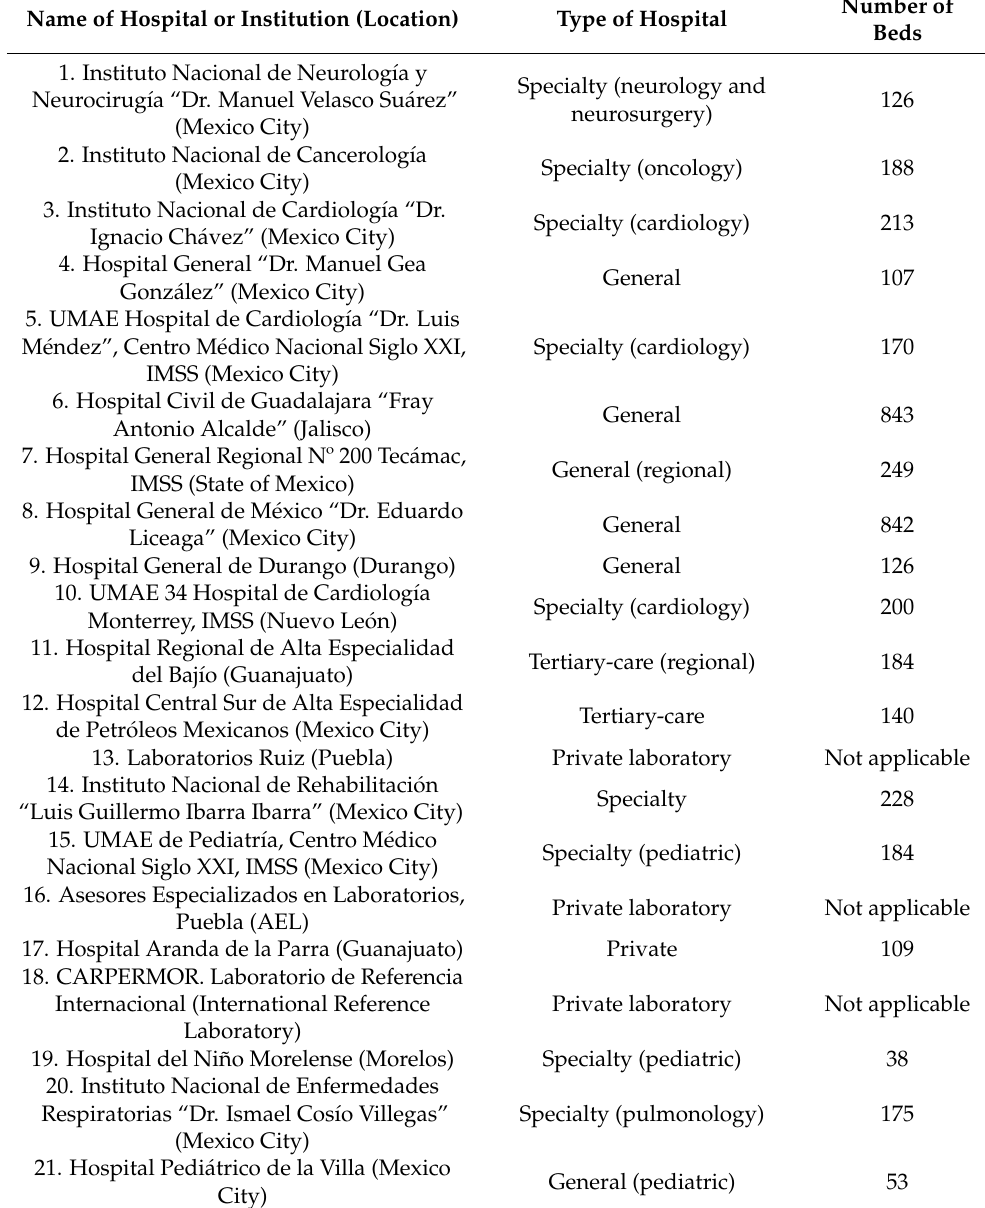
Table 1. Characteristics of hospitals/institutions participating in the study. Name of Hospital or Institution